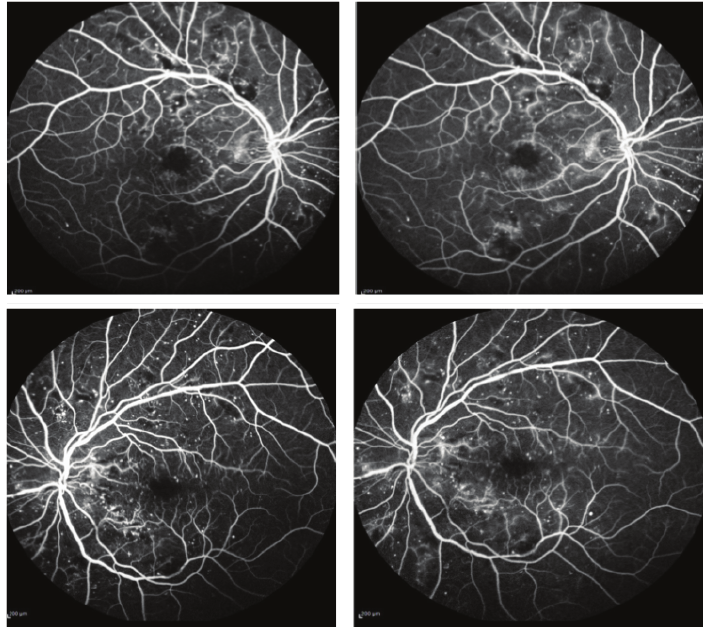
Figure 3. Fundus fluorescein angiography of the right (top left and right) and left (bottom left and right) eyes showing macular hypofluorescence, no vascular leakages and few areas of capillary non-perfusion.